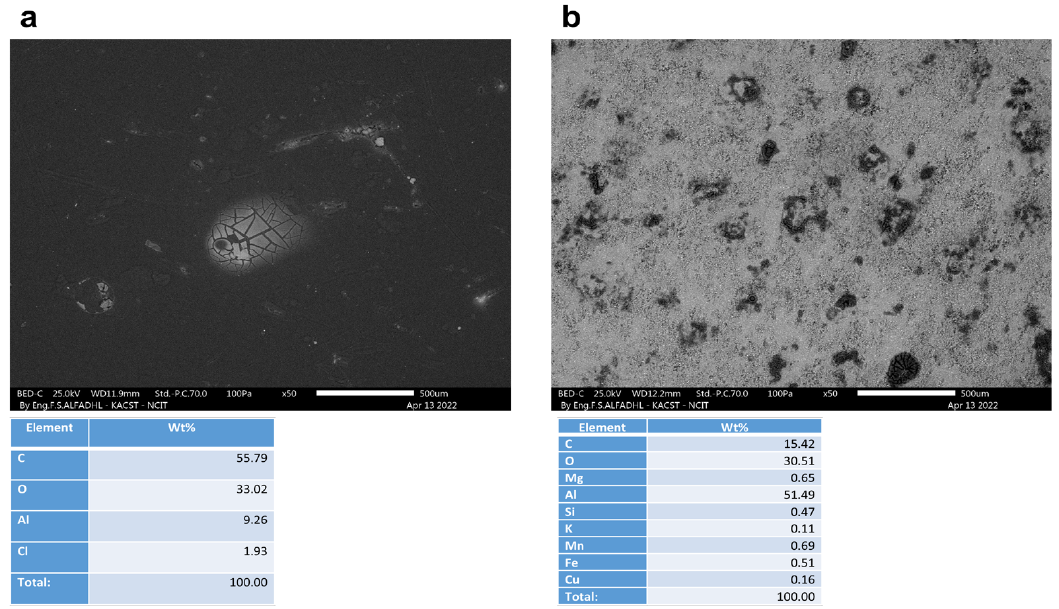
Figure 13. SEM and EDS analysis of Red Bull samples after corrosion tests under different conditions: ( a ) in acetic acid in the presence of an organic coating (WC) and ( b ) without an organic coating (WOC).